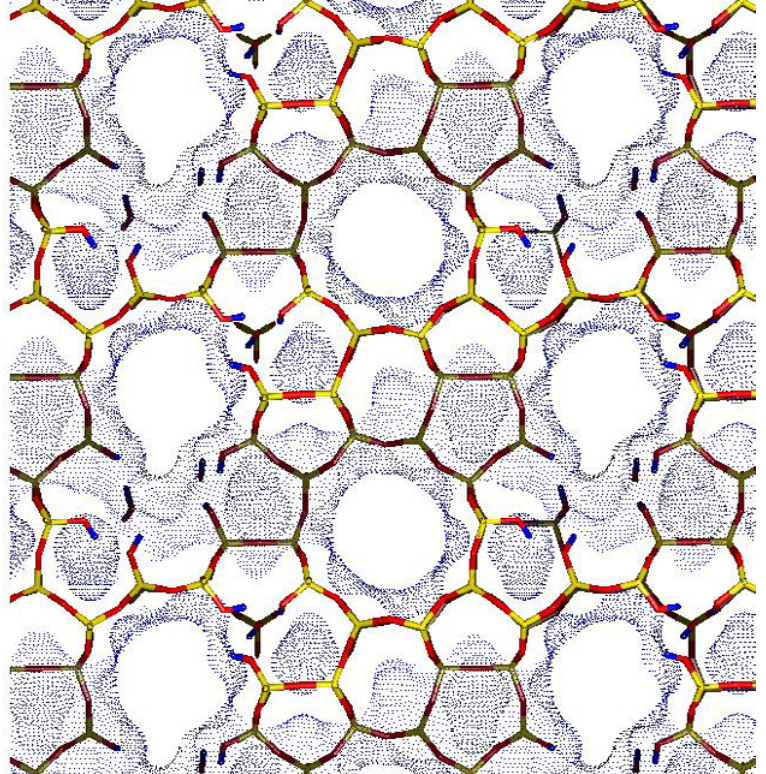
Figure 5: Model of a possible hydroxyl nest inside a defective silicalite, where six adjacent T7, T10 and T11 sites have been omitted. This nest is composed by 12 SiOH